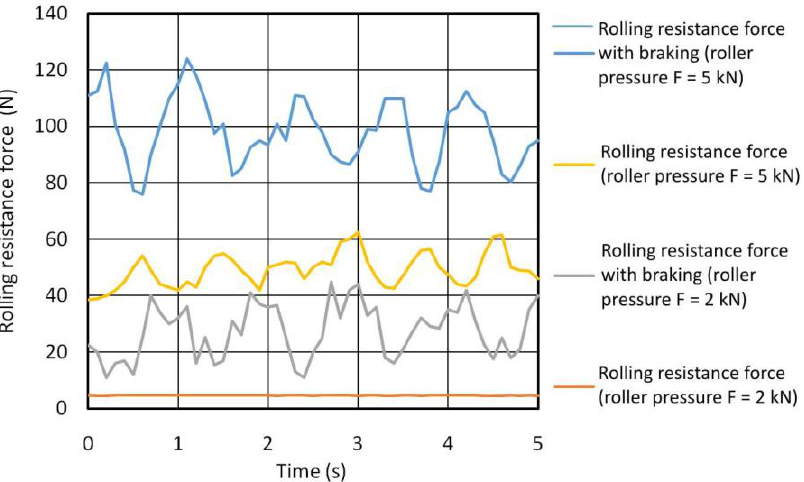
Figure 10. Rolling resistance force of the roller with and without braking applied to the roller.